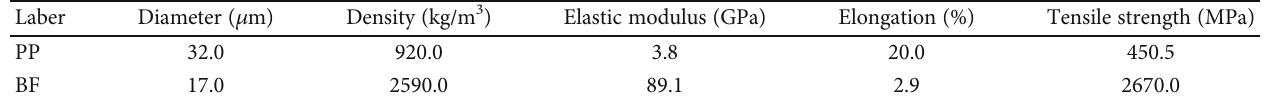
Table 4: Properties of PPs and BFs.